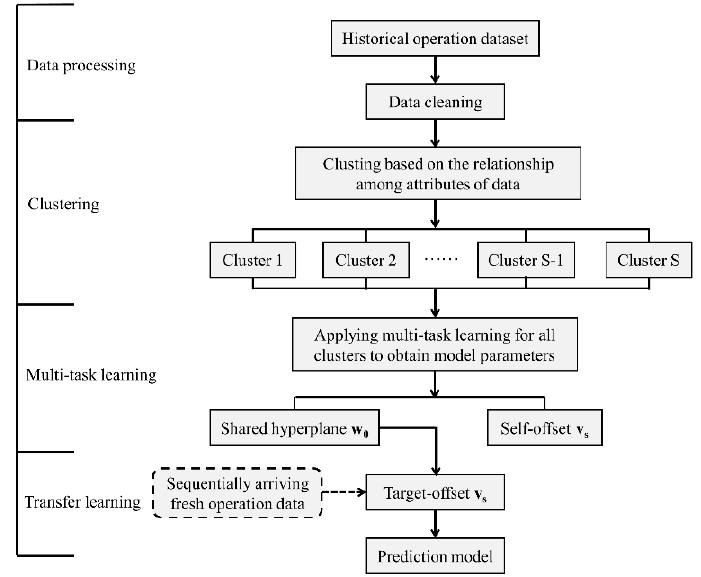
Figure 3. The proposed dynamic cutterhead torque prediction framework.